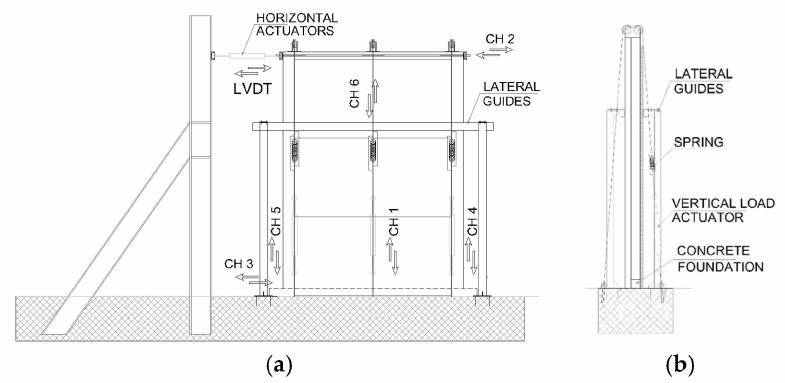
Figure 5. Test setup: ( a ) Frontal view and ( b ) Side view.